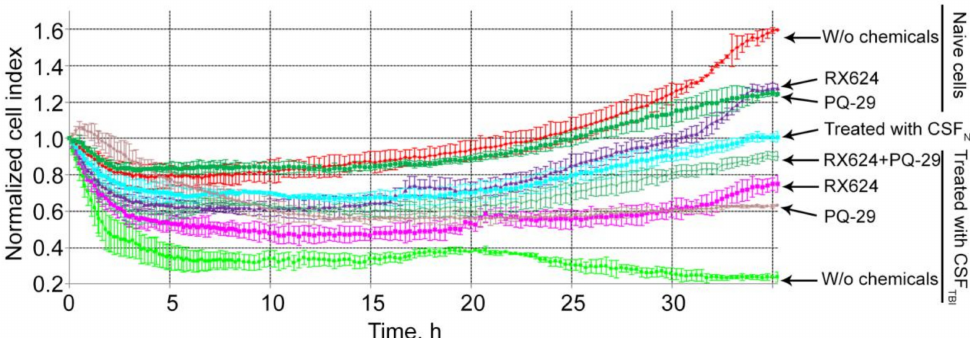
Figure 2. Dynamics of cellular index of C6 rat glioma cells cultivated in the presence of rat CSF, as well as RX624 and PQ-29 compounds. The data obtained using the xCELLigence setup are presented.